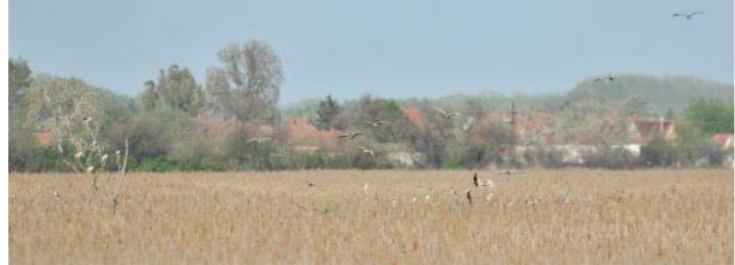
Figure 1. In the case of field counting, the birds will detect the approaching ornithologists from a long distance. Counting the individuals that are leaving or arriving at the site does not provide exact information about the size of the populations (capture by Örs Ábrám).